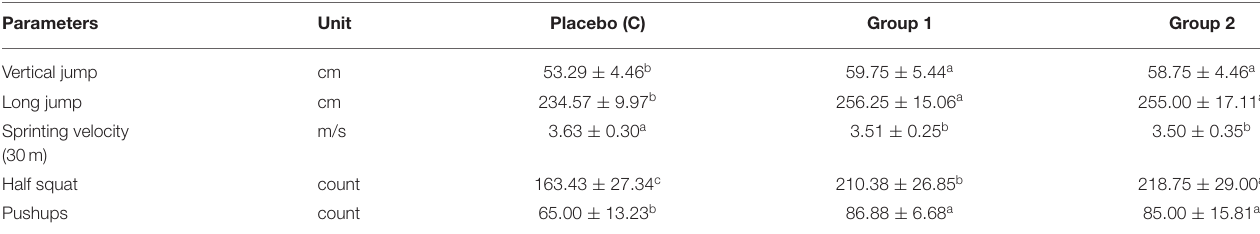
TABLE 4 | Influences of Pro-WPI products on athletic performance.